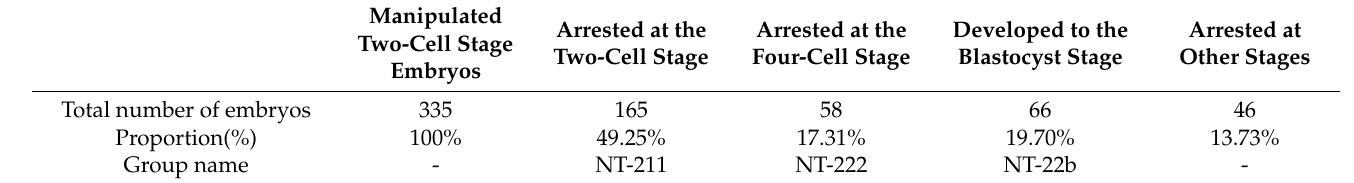
Table 1. The developmental fates of SCNT pig embryos after isolation of a blastomere at the two-cell